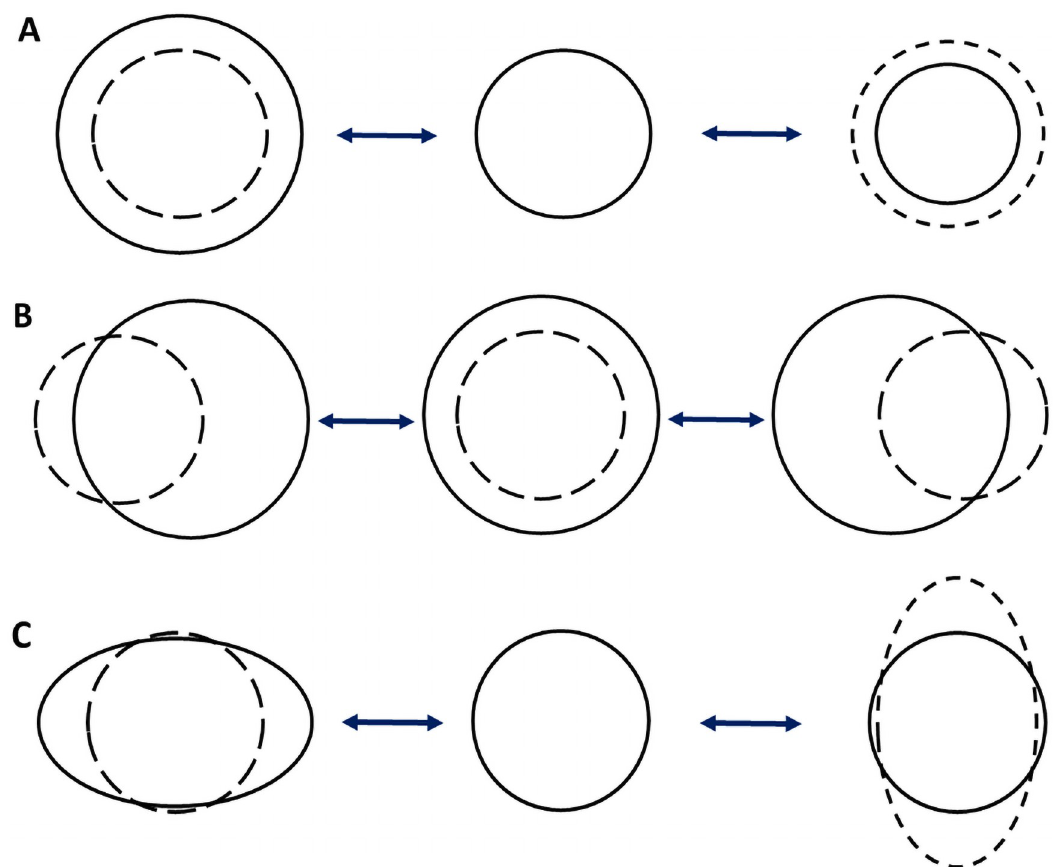
Fig 1. Illustration of oscillations in spherical particles with core-shell charge separations. (A) monopolar, (B) dipolar and (C) quadrupolar modes. The dotted and undotted lines represent relative opposite charge densities respectively.